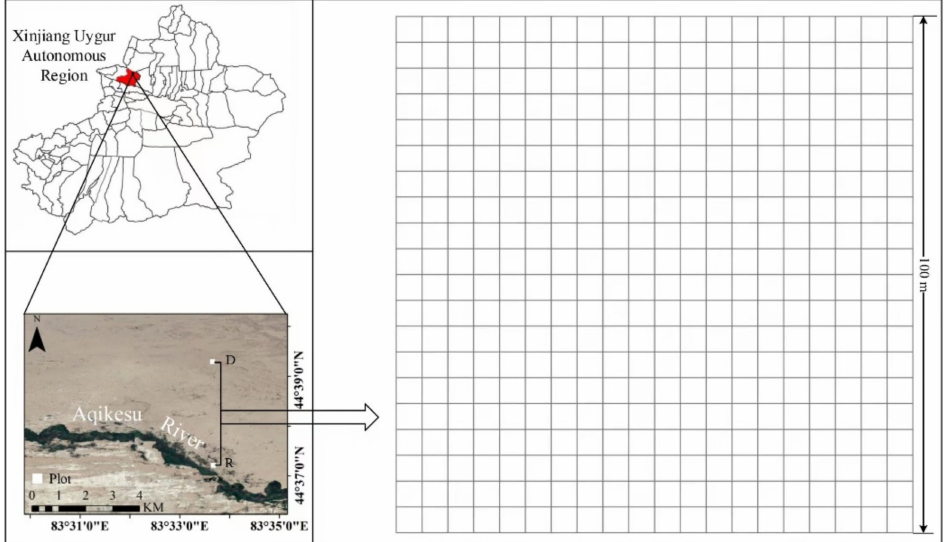
Figure 1. The study area and location of the plots. Note: R and D represent the plant communities of the river bank and desert margin,